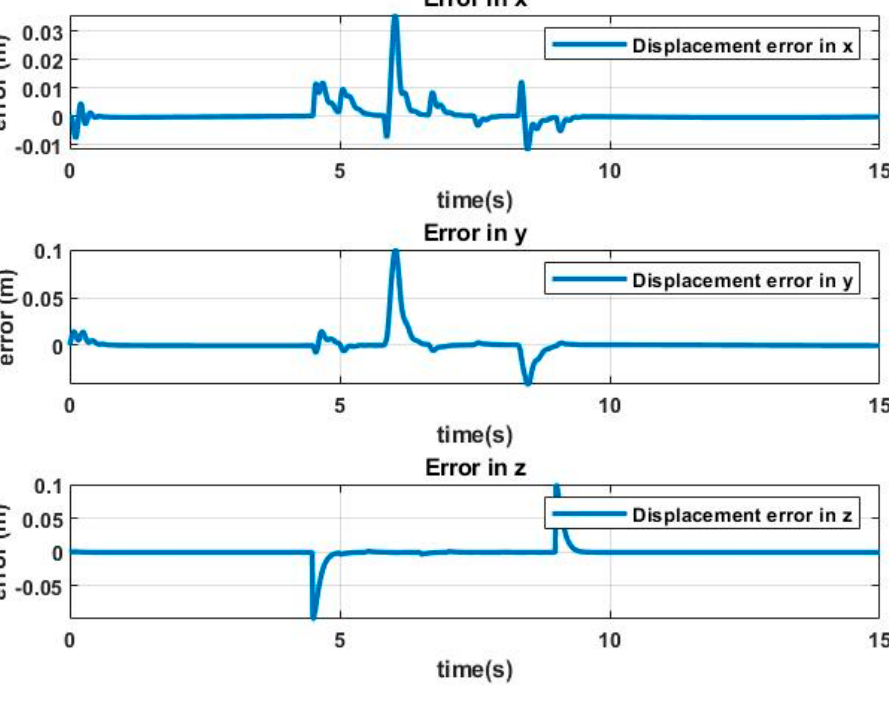
Figure 19. Relative orientation errors vs. time from task with perturbance. Tests show that the controller is capable of following trajectories even in the presence of initial errors or random disturbances, such as those that can cause air currents in a flight. The system correctly manages the added error within a short response time because of the correct tuning of the